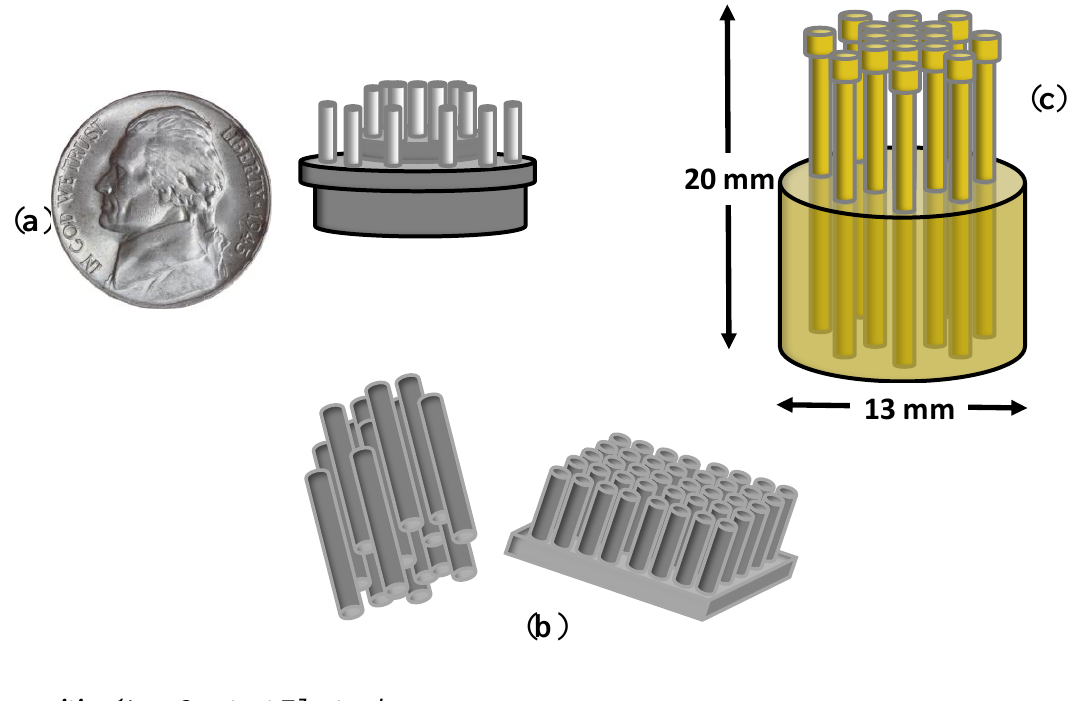
Figure 3. ( a ) Ambulatory Wireless EEG System Adapted from [17]; ( b ) Polymer bristles. Adapted from [18]; ( c ) Spring contact probes. Adapted from